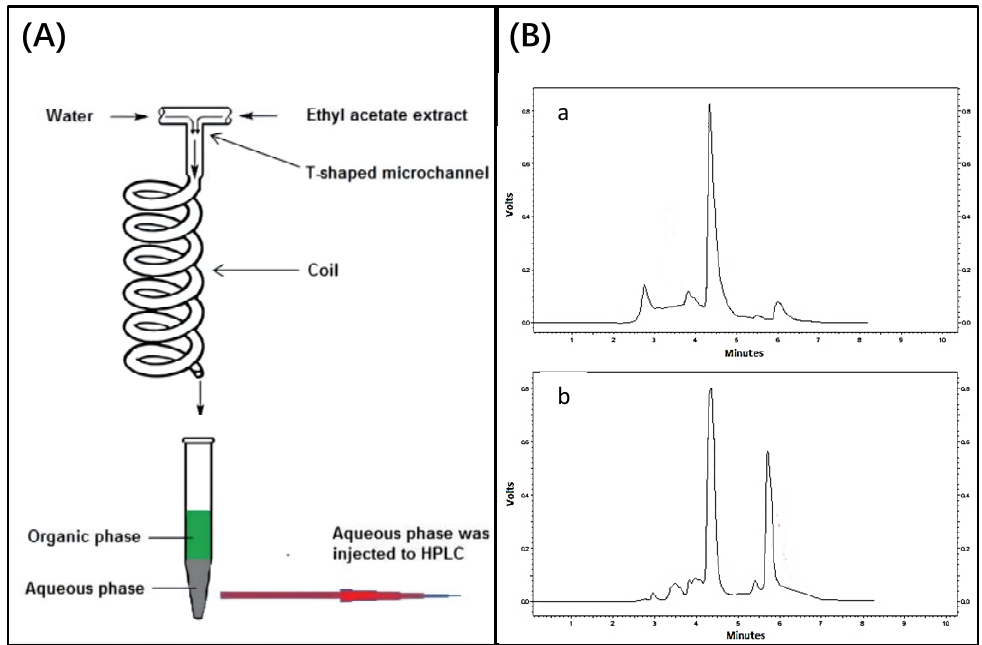
Figure 9. Schematic diagram of the extraction of olive bitter glycosides by Microfluidics: ( A ) Microfluidic device. ( B ) Chromatogram of extracted olive bitter glucoside into aqueous phase: microchannel device (Ba) and ethyl acetate extract (Bb). The image from [5], Copyright 2018, Herbal Medicines Journal.